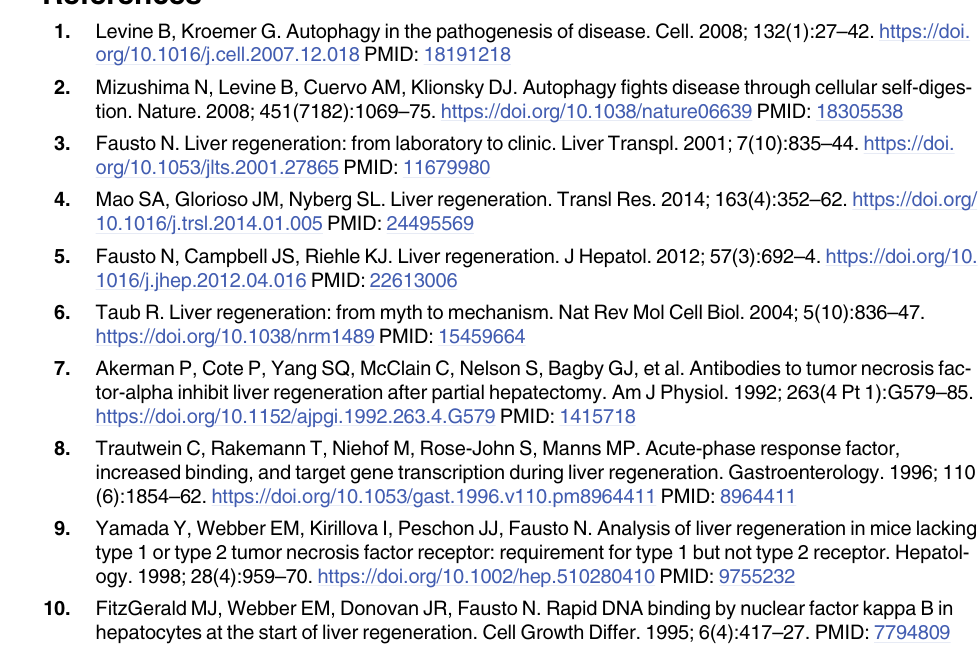
as a loading control. (B) Immunoblot analysis of changes in Beclin-1, LC-I and LC-II protein expression levels in L-Atg5 KO mice in the different organs. (TIF) S2 Fig. Actin in mitochondria and COX IV in cytoplasm were isolated successfully. (TIF) S1 Raw